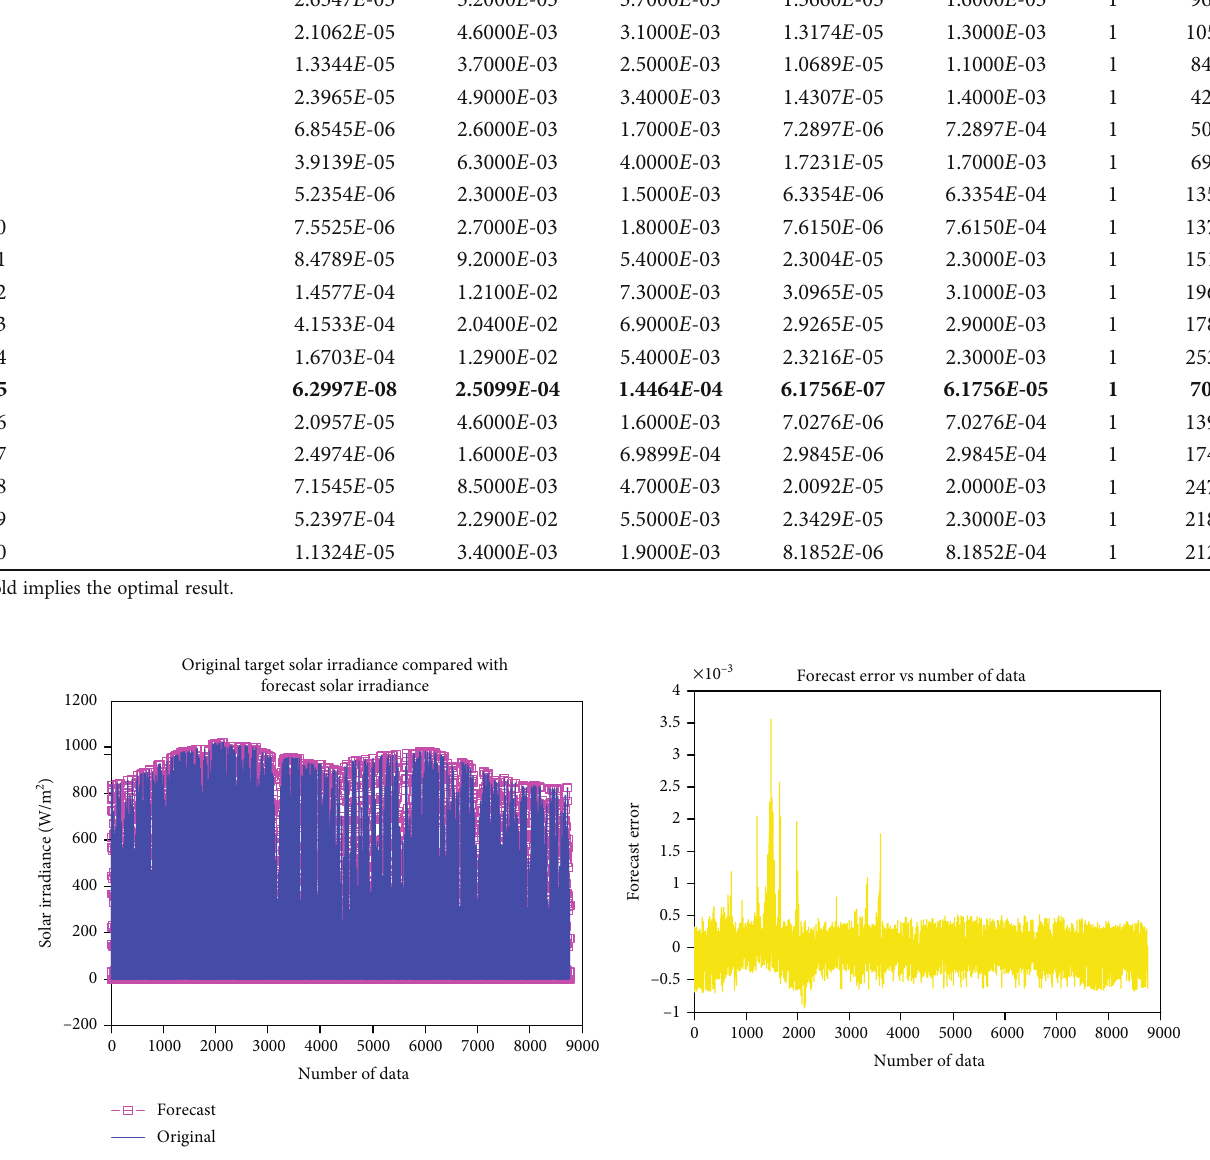
vs. number of data samples and Figure 9(a): three input MLPNN-based forecasting model regression graphs. The